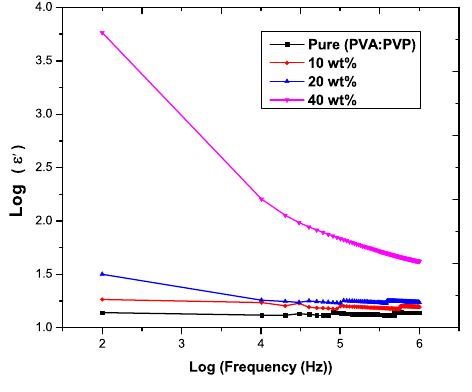
Figure 2: Log-Log plot of the dielectric constant as a function of the frequency of pure and PVA:PVP poly- mer blend films reinforced with different weight ratios of CdCl 2 · H 2 O